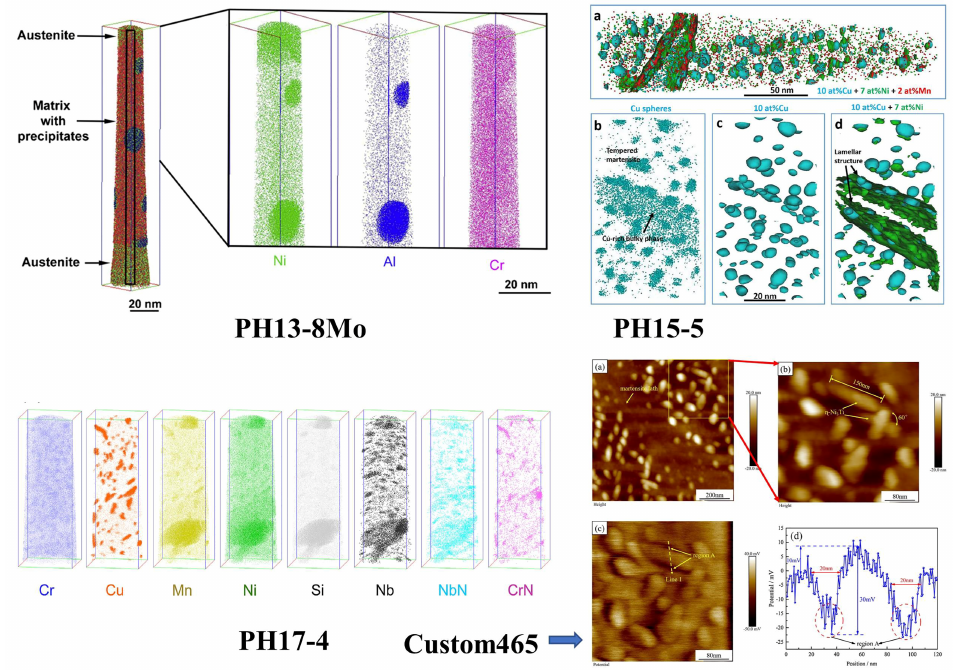
Figure 5. Characteristic nanoprecipitate microstructures in various PHSS: PH13-8Mo [15];